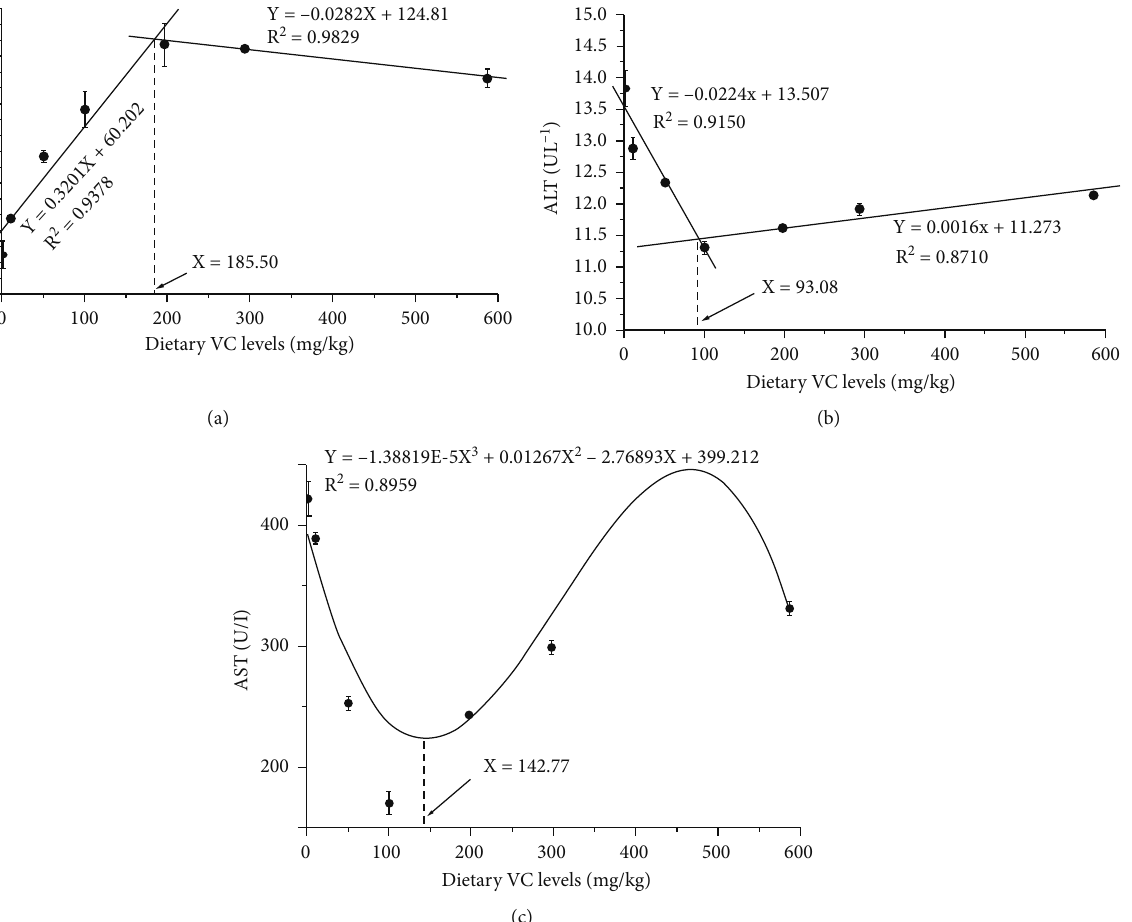
Figure 3: Broken-line analyses of AKP and ALT and cubic regression analysis of AST with dietary vitamin C (VC) levels in coho salmon Oncorhynchus kisutch (Walbaum, 1792) postsmolts. The predicted dietary VC requirements of AKP, ALT, and AST are 185.50, 93.08, and 142.77mg/kg, respectively. Abbreviation: AKP: alkaline phosphatase; ALT: glutamic pyruvic transaminase; AST: glutamic oxaloacetic